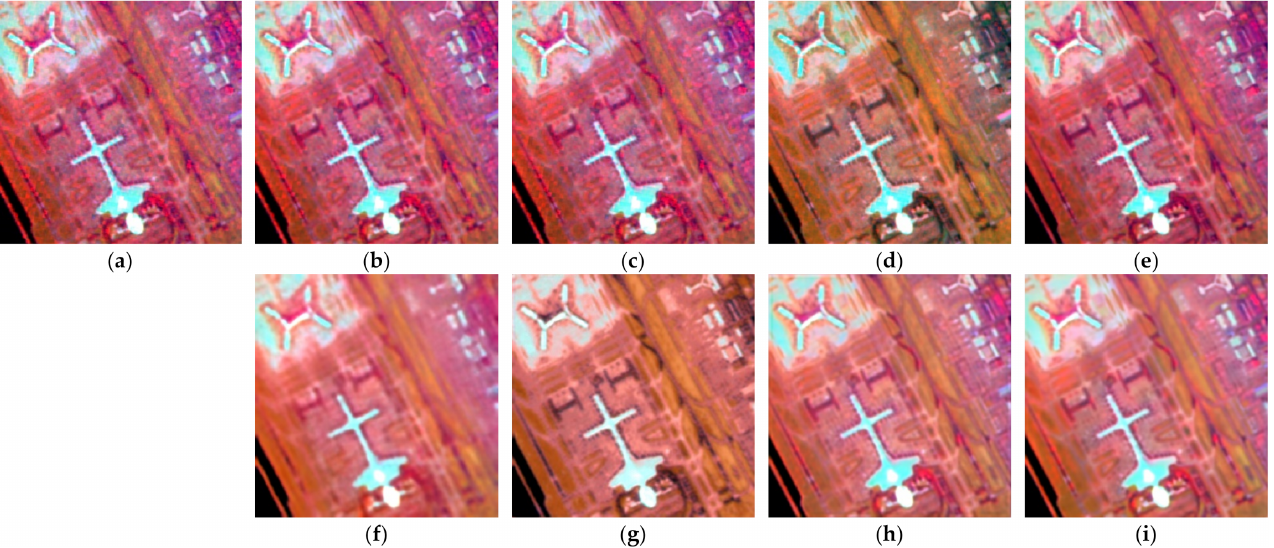
Figure 16. ZH-1 hyperspectral image denoising results with false-color image (R: band 32, G: band 20, B: band 1): ( a ) real image; ( b ) BM4D; ( c ) LRMR; ( d ) HyRes; ( e ) L1HyMixDe; ( f ) DHP-2D; ( g ) SIP;